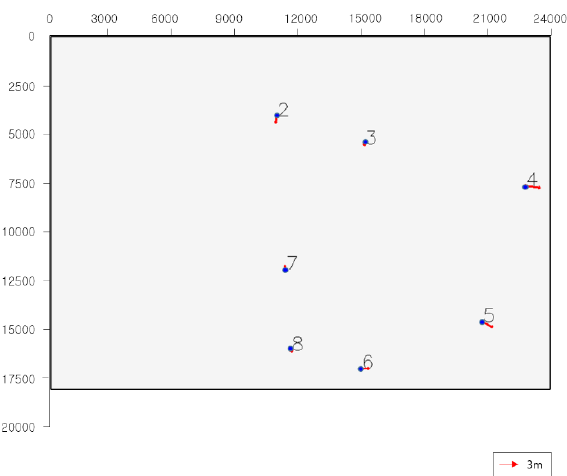
Figure 7. Geometric errors in precise orthoimage of Seoul compared with aerial